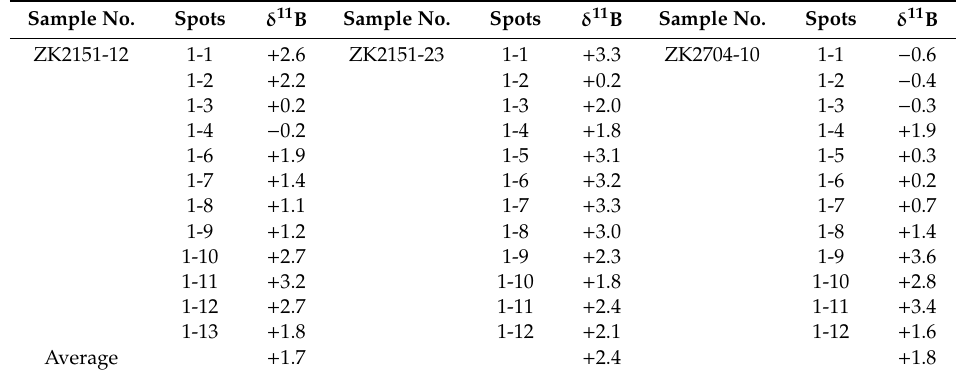
Table 3. In-situ laser ablation multi-collector inductively coupled mass spectrometer (LA-MC-ICPMS) B isotopic compositions (% (cid:24) ) of tourmaline from the wall rocks of the Zhaoanzhuang iron deposit. Sample No.